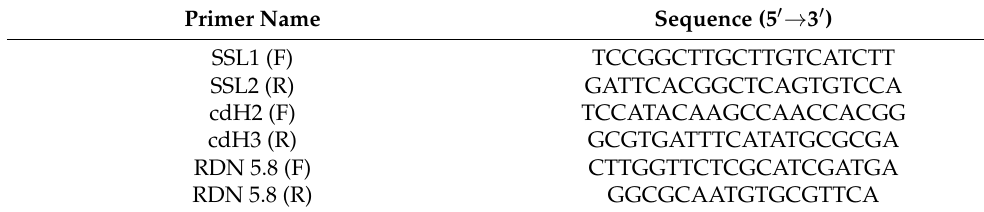
Table 2. Primers used for RT-qPCR of swnT